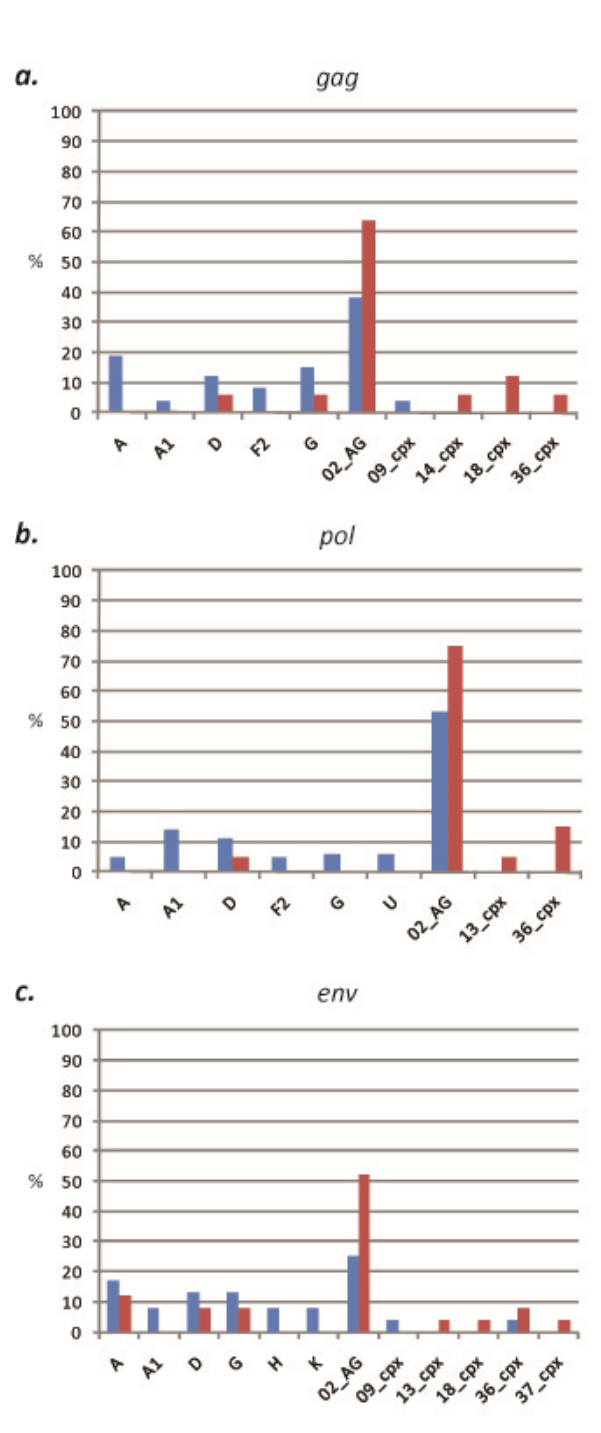
Figure 2. Percentages of each (sub)subtype and CRF at each locus, South region. (a) gag